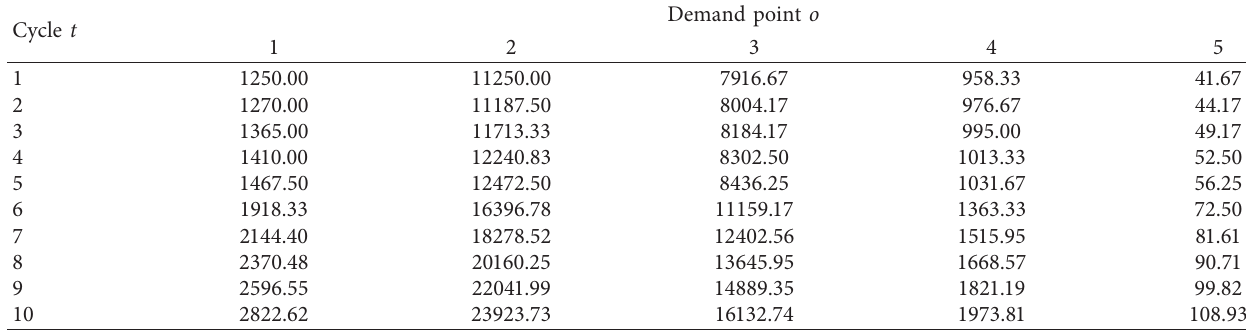
Figure 5: Biodiesel demand in Jiangsu Province. Table 3: Biodiesel demand information of Jiangsu